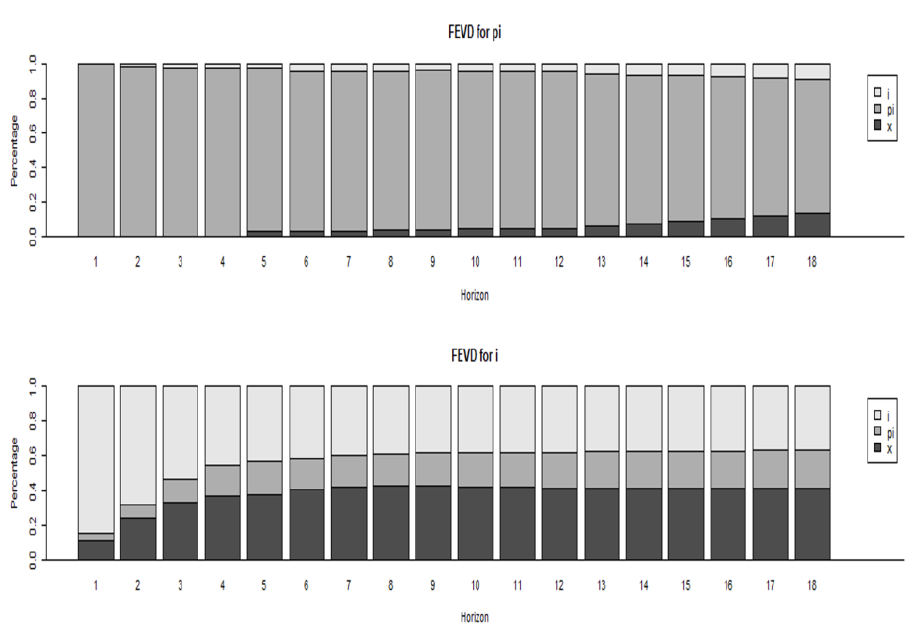
Figure 6: The Forecast Error Variance Decomposition of the SVAR model results; Source: Author’s